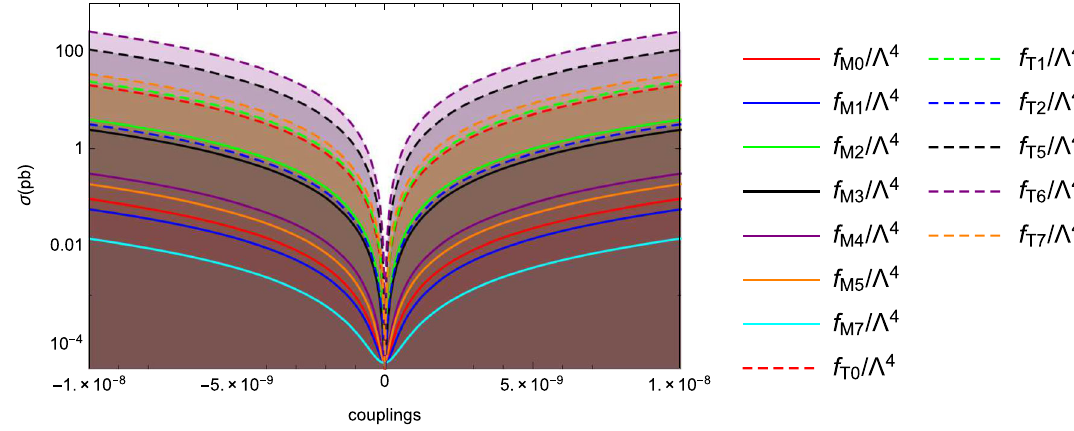
√ s = 1 . 98 TeV at the LHeC